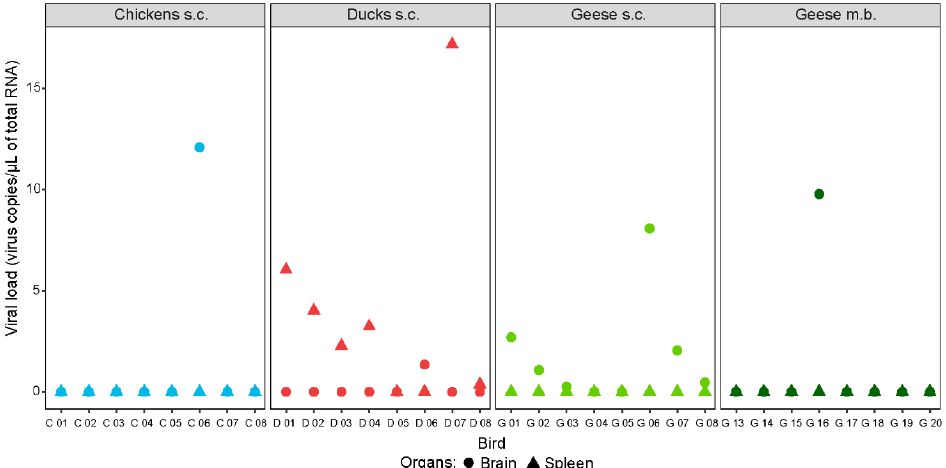
Figure 4. Selected organ samples of chickens (in blue), ducks (in red), and geese (in green) infected with WNV via subcutaneous injection (s.c.) or the bite of WNV-infected mosquitoes (m.b.). Brain samples depicted as filled circles and spleen samples as filled triangles. All birds were euthanized 19, 20, or 21 dpi, except for one duck (D 07) that succumbed 2 dpi.